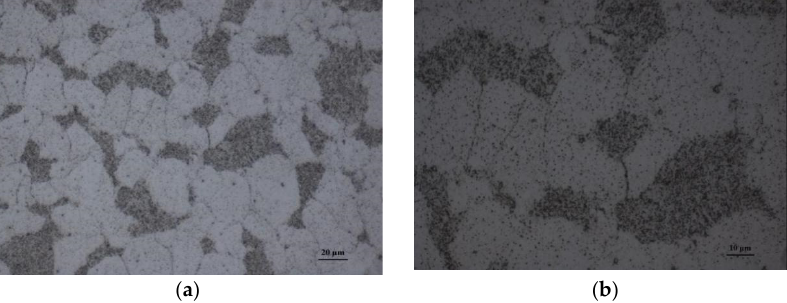
Figure 6. Metallographic structure of inner surface in the 270° direction. ( a ) 500×, ( b ) 1000×.